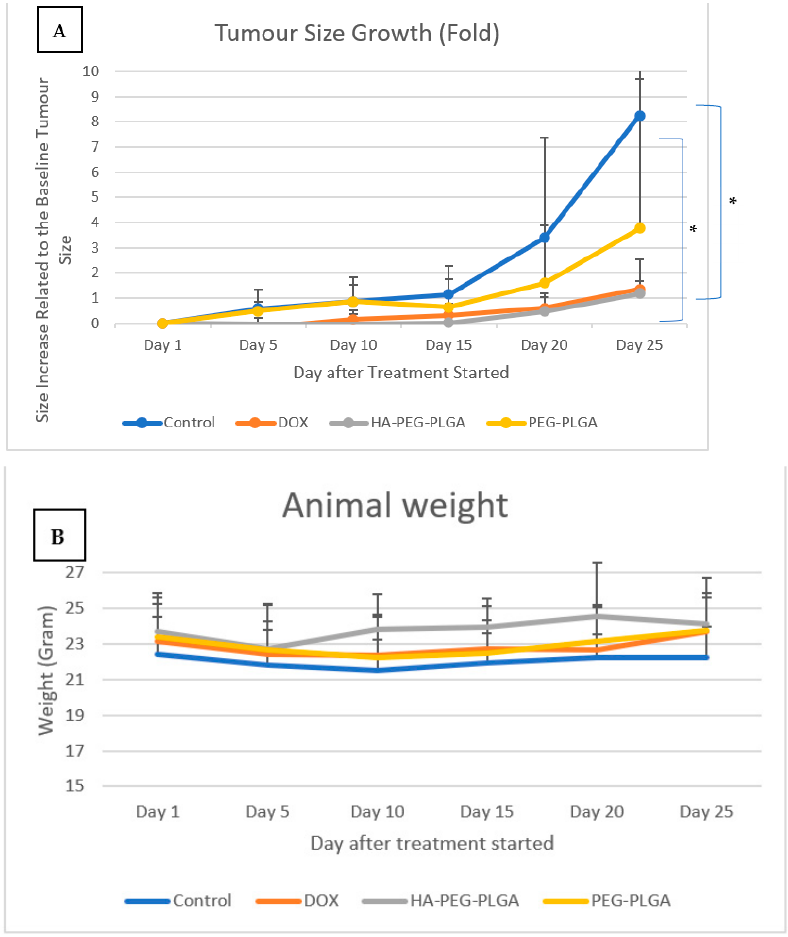
Figure 3. ( A ): Primary tumour growth results presented in fold increase relative to day 1. * Indicates p ≤ 0.05 compared to control, ( B ): Animal weight (DOX: free doxorubicin, PEG-PLGA: Doxorubicin loaded PEG-PLGA nanoparticles, HA-PEG-PLGA: Hyaluronic acid coated Doxorubicin loaded PEG-PLGA nanoparticles).